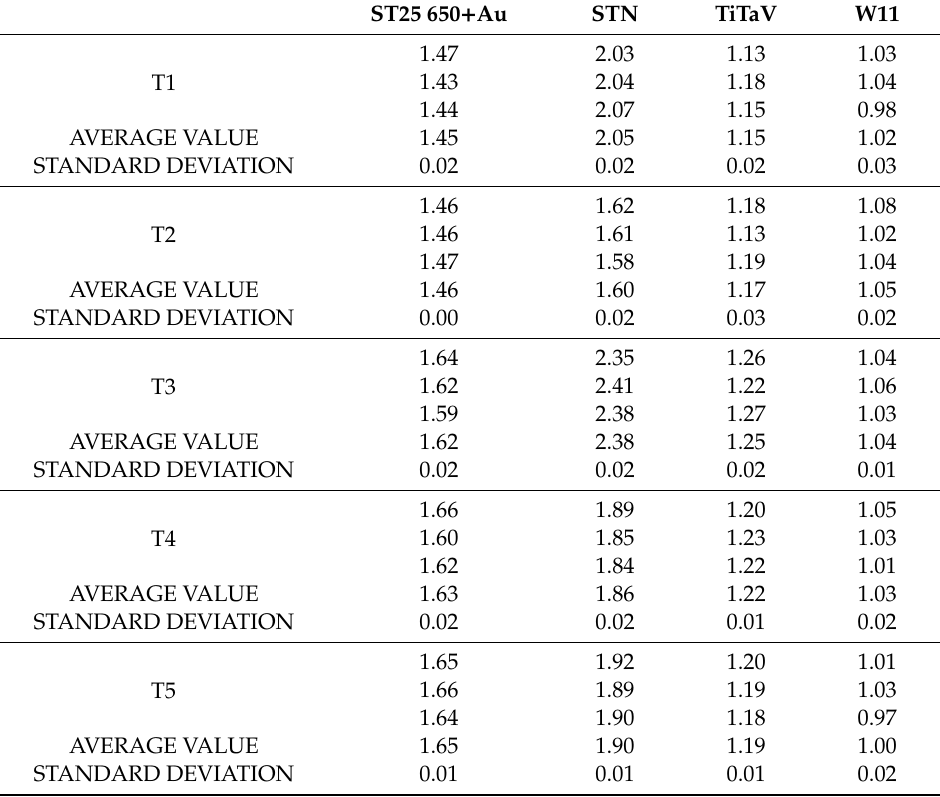
Table 6. Data, average values and, standard deviations from blood tests on tumor a ff ected samples shown in Figure